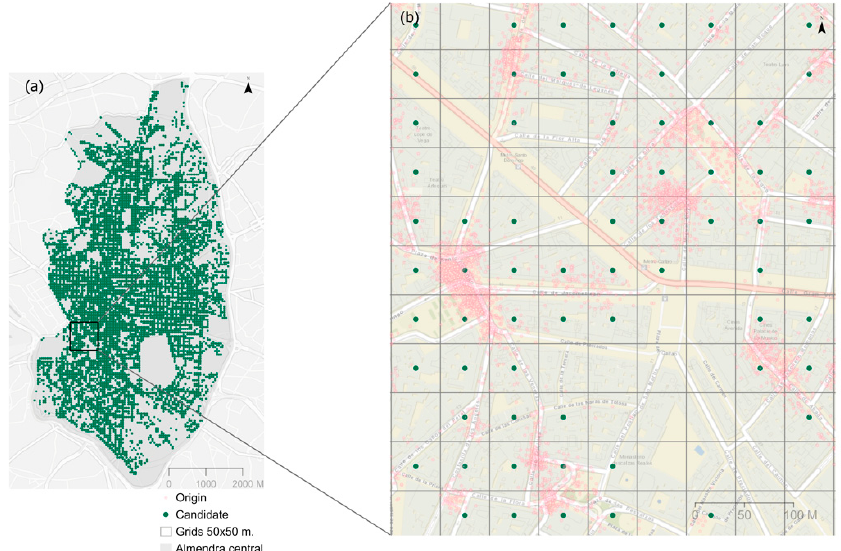
Figure 3. Locations considered as candidates in the models. ( a ) Total locations; ( b )